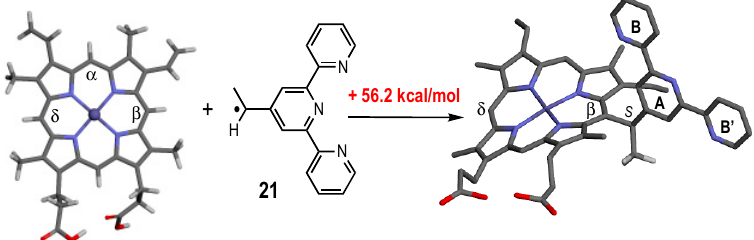
Scheme 6. Computed free energy (B3lyp/3-21G*) of alkylation of heme at the β - meso position, by the